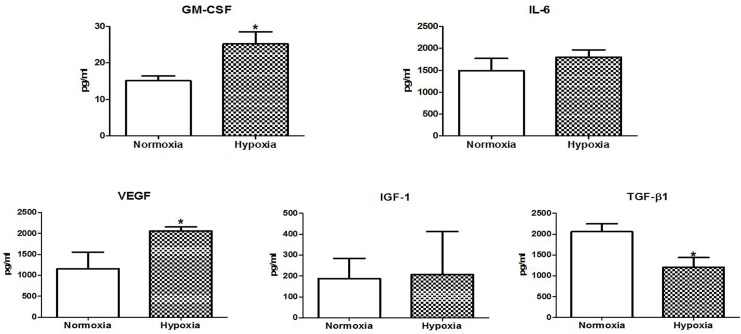
Secretome analysis.Concentrations of cytokine and growth factors released by hAdMSC were measured after hypoxia preconditioning with O2 at < 5% for 6 hours using multiplex antibody arrays. Data displayed are from the hAdMSC secretomes generated under normoxia and hypoxia. Mann-Whitney test (A) GM-CSF, P = 0.048, (B) IL-6, P = 0.3914, (C) VEGF, P = 0.044, (D) IGF-1, P = 0.936; n = 3. Each sample was measured in duplicate.